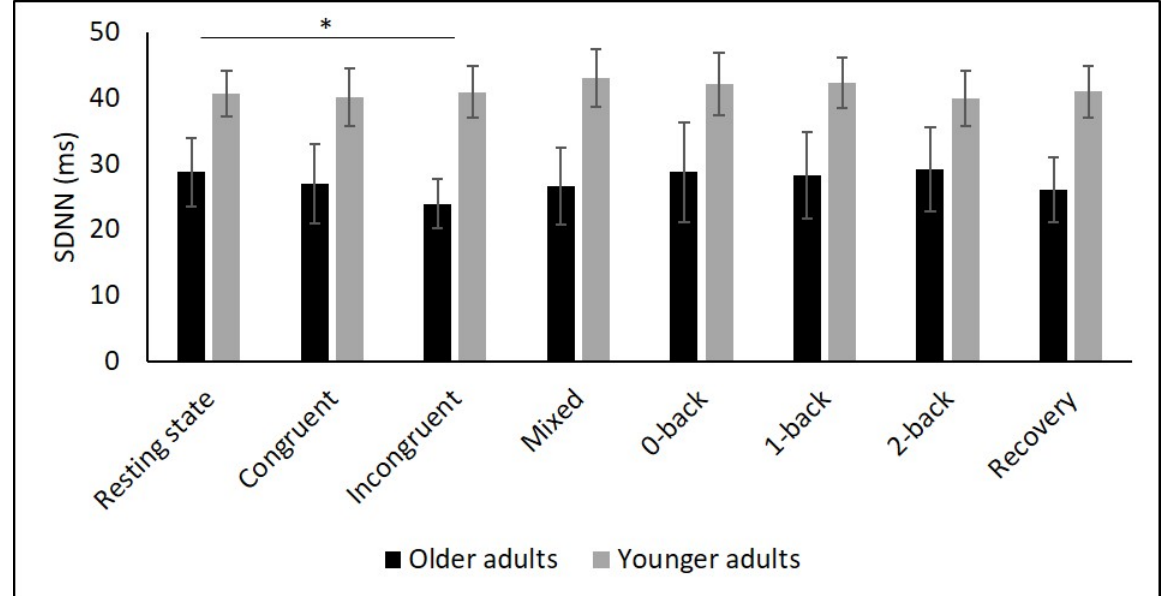
Figure 3. Means and group × condition interactions for SDNN. Error bars indicate ±2 standard error of mean; abbreviations: ms: milliseconds; SDNN: standard deviation of the NN intervals. * p <